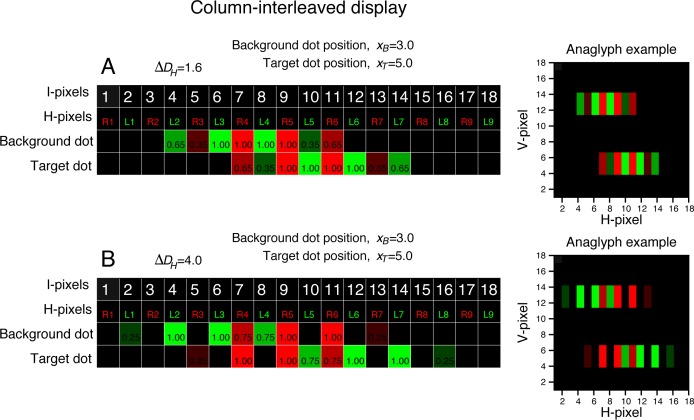
Avoiding position and monocular artifacts: examples with antialiasing. (A) Example showing a background dot and a target dot with relative parallax of ΔDH = 1.6 H-pixels. The position of the background dot is xB = 3 and the position of the target dot is xT = 5. The final position of the target and background once the relative parallax is applied was calculated according to Equation 2. The dots are 4 H-pixels wide. The number inside the squares represents the digital driving level (see main text for details). (B) Same details as in panel A, but the relative parallax is ΔDH = 4 H-pixels. The images on the right present the dots in an anaglyph version (the red filter should be placed in front of the right eye).